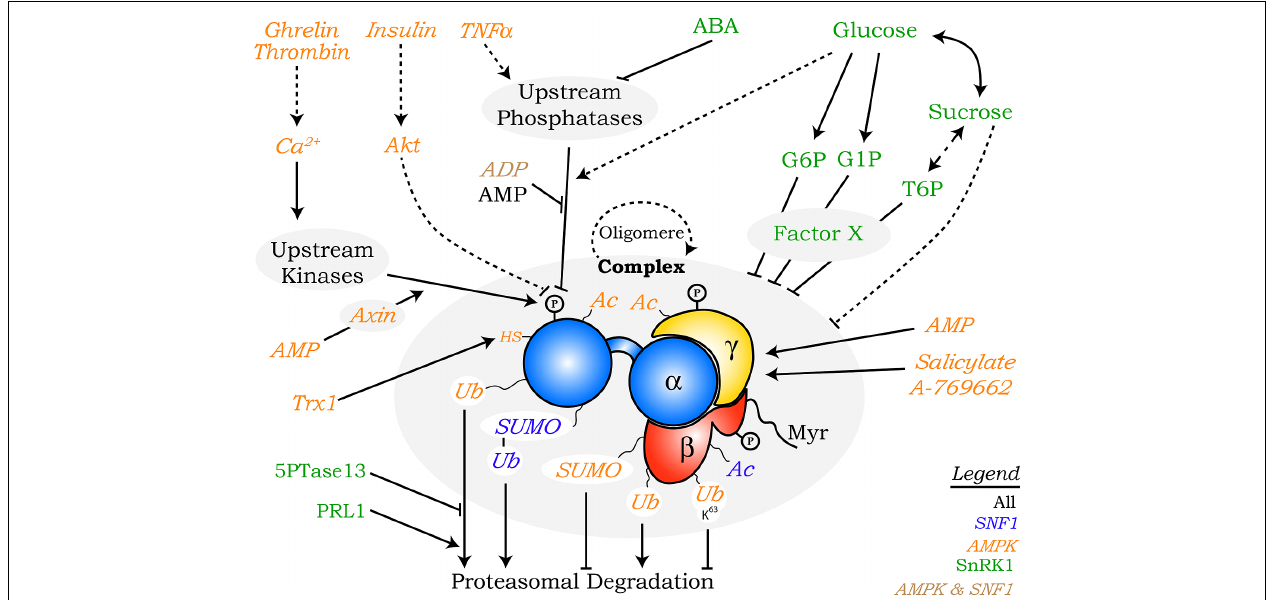
whereas in other cases regulation of the complex as a whole (“complex”) is indicated. Broken lines and full lines designate indirect links and direct connections, respectively. P, phosphorylation; Ac, acetylation; Ub, ubiquitination; Ub K63 , ubiquitination through K63 chains; SUMO, small ubiquitin-like modifier; Myr, myristoylation; HS, reduced cysteine; Trx1,